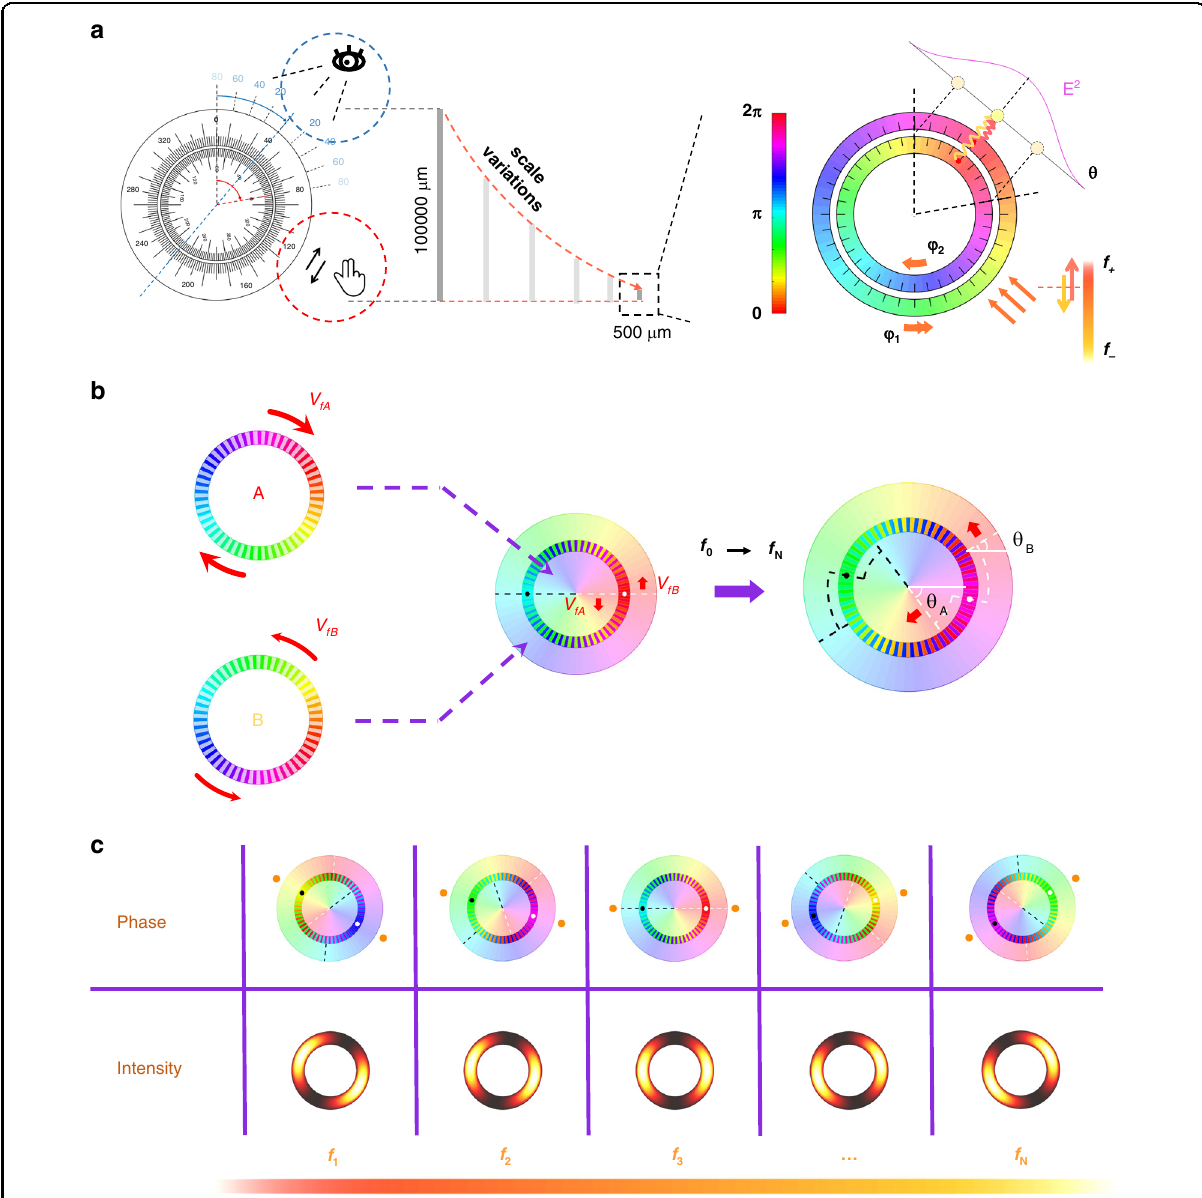
Fig. 1 Concept of the metasurface design. a The conventional slide rule (left) is driven by mechanical rotation and read out visually with an easy- to-use size. As an analog, an ultracompact prototype of the photonic counterpart (right) based on the metasurface platform is shown. The metadevice is designed with the incident frequency and polarization state function with varying phases. Correspondingly, angle-resolved interfered spots are observed in the far- fi eld. b The schematic of the interference evolution of two phase groups at different frequencies. The interference pattern changes with the incident frequency. c The expected overall performance of the metadevice at the sampling frequencies. The interfered annuluses rotate with the frequency, thus providing a route to recognize the wavelength of incident